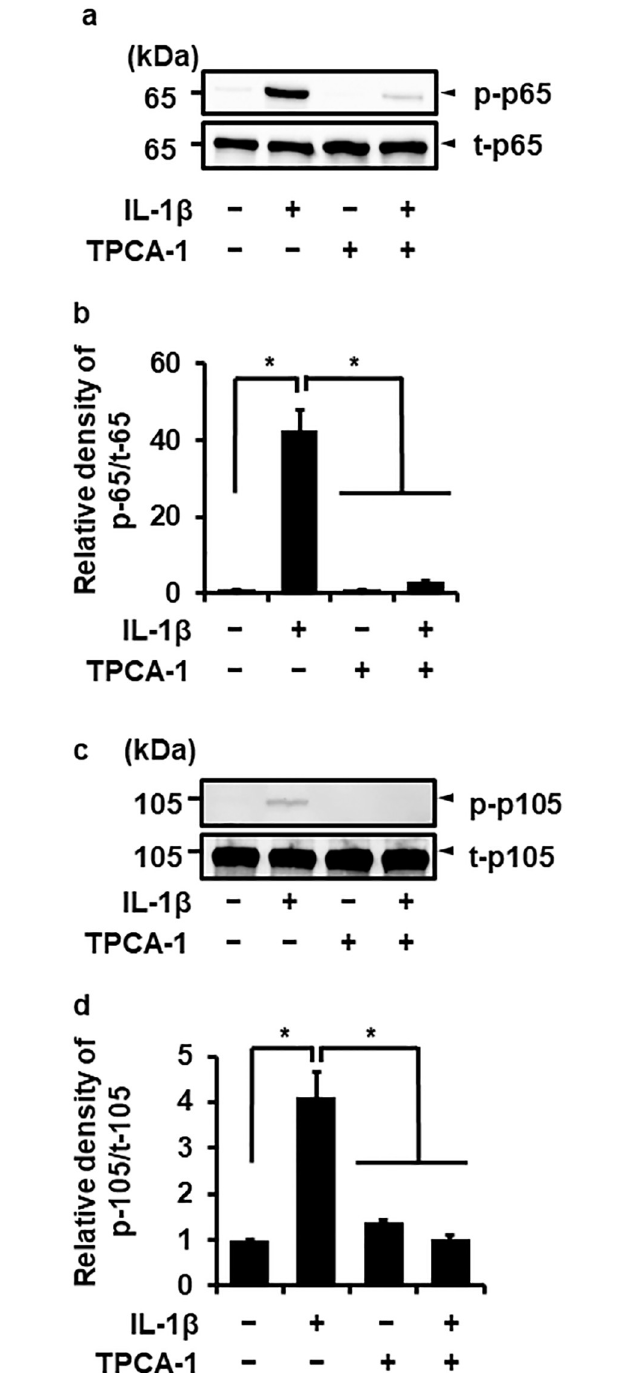
Fig 3. Effect of the NF- κ B inhibitor on the IL-1 β -induced phosphorylation of p65/RelA and p105. The cells were pretreated with the NF- κ B inhibitor, TPCA-1 (10 μ M, 1 h), followed by the stimulation of IL-1 β (100 pM) for 15 min. Phosphorylated p65/RelA (p-p65) and p105 (p-p105), and total p65/RelA (t-p65) and p105 (t-p105) were detected by Western blotting. Representative images of the inhibitory effect of TPCA-1 on IL-1 β -induced phosphorylation of p65/ RelA (a) and p105 (c) are shown. The relative levels of [p-p65]/[t-p65] (b) and [p-p-105]/[t-105] (d) relative to levels without the inhibitor and IL-1 β are illustrated. The results are represented as mean ± SE of biological triplicates. � P <